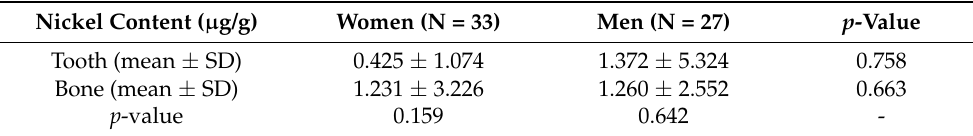
Table 13. Nickel content in tested samples taken from patients of different